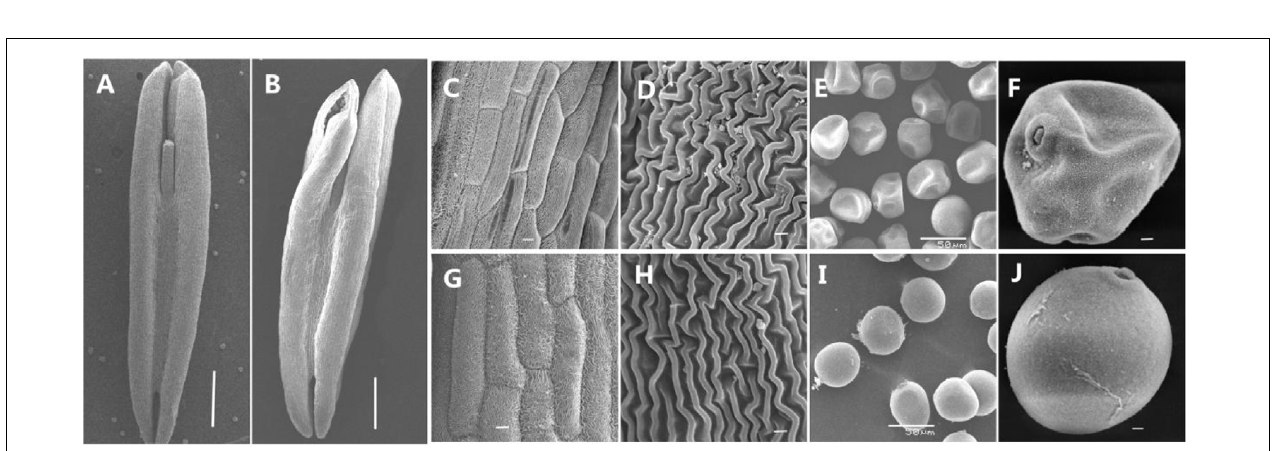
Frontiers in Plant Science |